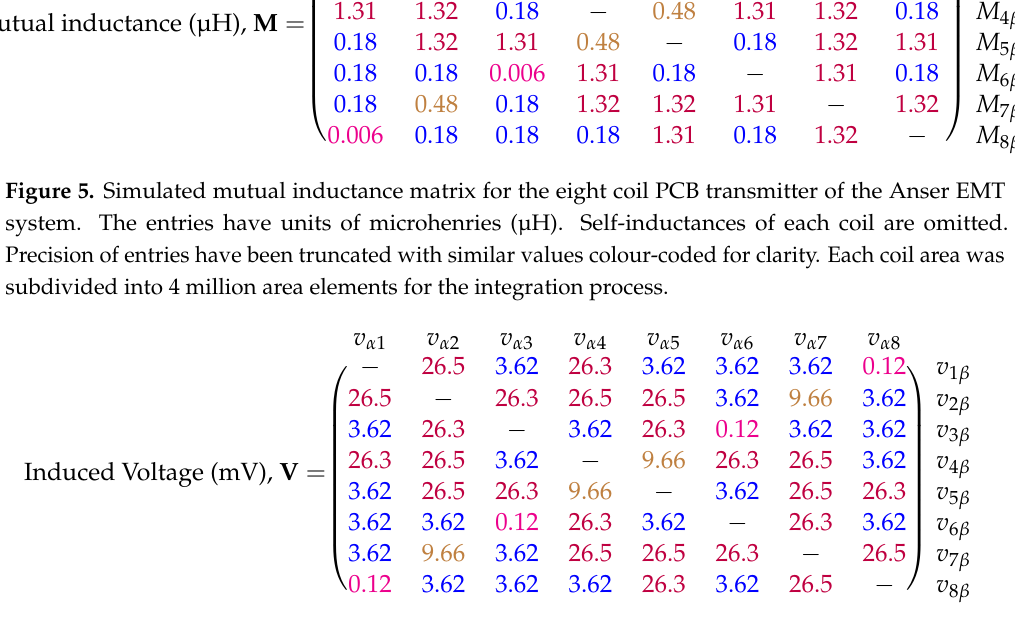
Figure 6. Simulated induced peak-voltage matrix for the eight coil PCB transmitter of the Anser